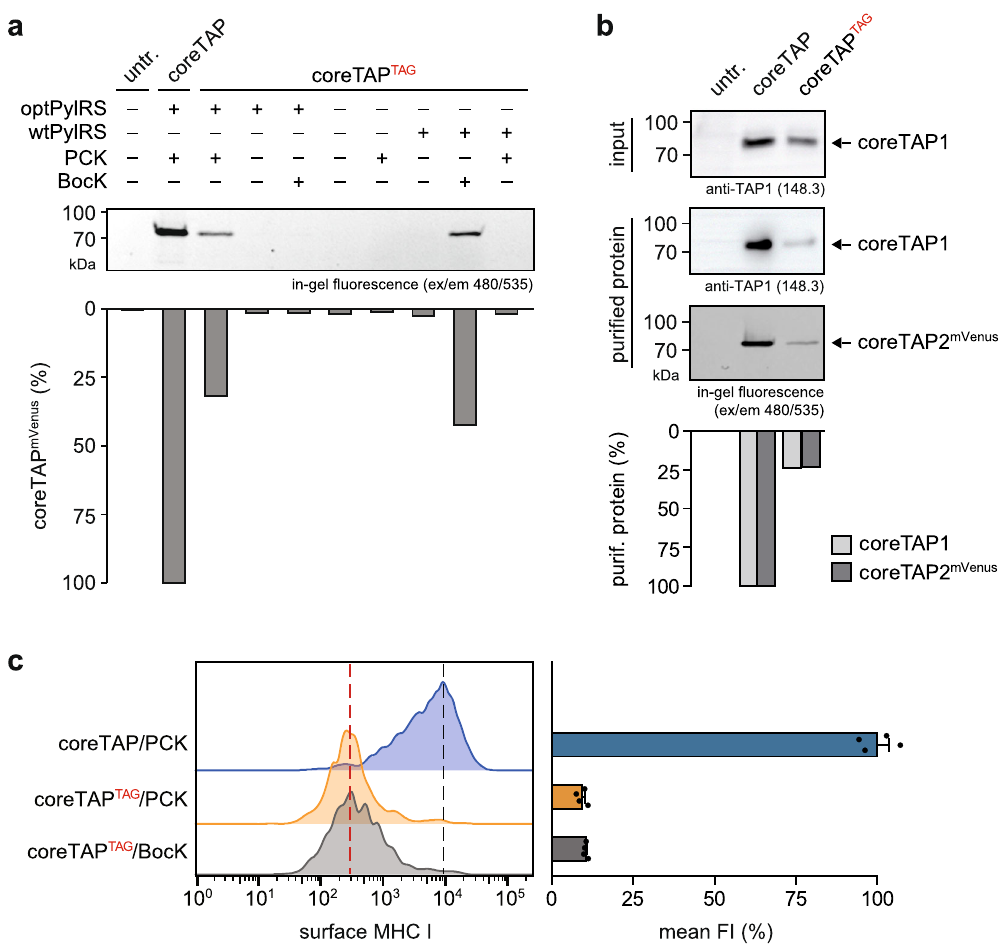
Fig. 3 UAA incorporation in the canonical ATP-binding site of TAP blocks antigen presentation. a TAP2-de fi cient STF1-169 cells co-expressing coreTAP TAG and wtPylRS or optPylRS in the presence of BocK or PCK were analyzed by SDS-PAGE and mVenus in-gel fl uorescence. CoreTAP served as reference and was utilized to normalize the fl uorescence intensities. untr. untransfected cells. b Puri fi ed coreTAP/PCK and coreTAP TAG /PCK were analyzed by SDS-PAGE, in-gel fl uorescence (mVenus), and immunoblot (anti-TAP1). To analyze the subunit stoichiometry of the puri fi ed TAP1/2 complex, the coreTAP1 signal of the input (cell lysate) was used for normalizing. c Surface MHC I expression in TAP2-de fi cient STF1-169 cells co-expressing coreTAP or coreTAP TAG and optPylRS in the presence of PCK or coreTAP TAG and wtPylRS in the presence of BocK. Flow cytometric analysis was performed by using an APC-Fire750-labeled HLA-A, B, C-speci fi c antibody (W6/32). The black dotted line represents the mode of cells expressing coreTAP, while the red dotted line represents the mode FI of cells expressing the amber-suppressed variants. The mean FI of MHC I surface expression was normalized to coreTAP/PCK (± SEM, n = 4, biologically independent samples). FI fl uorescence